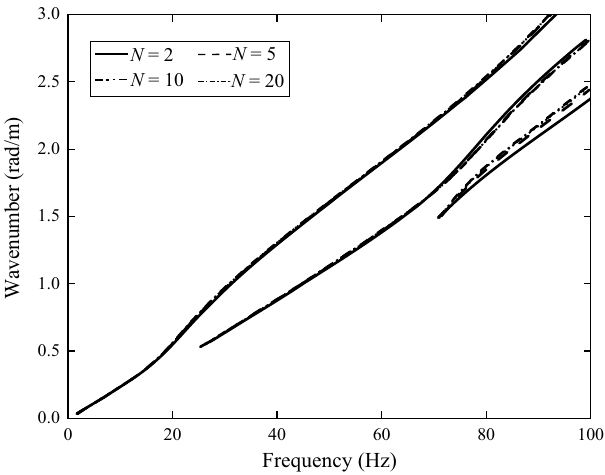
Figure 9. Dispersion diagram of frozen ground with different layers ( T 0 = − 20 °C, h frozen = 2.5 m).